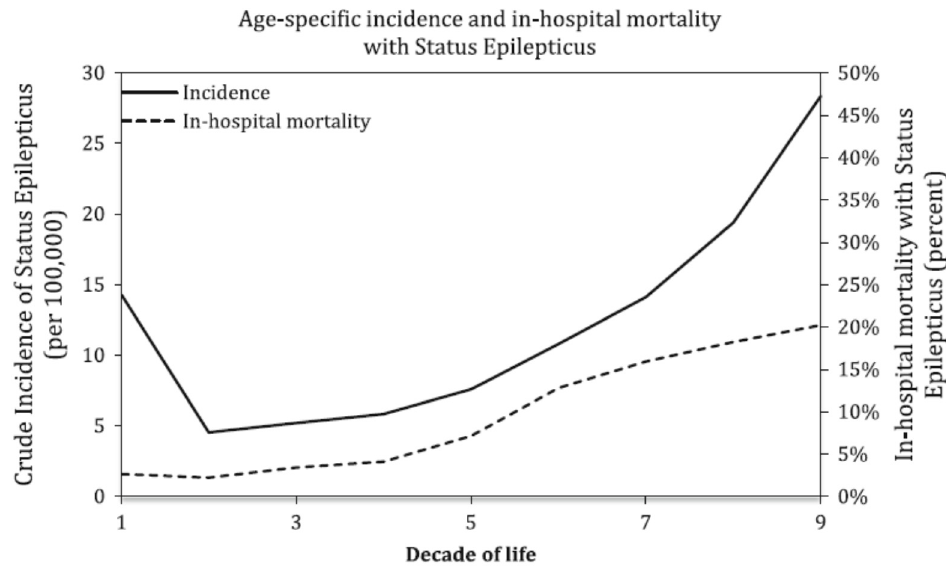
Figure 2. Age-specific crude incidence and in-hospital mortality with status epilepticus. Taken and adapted from Dham et al. [8].